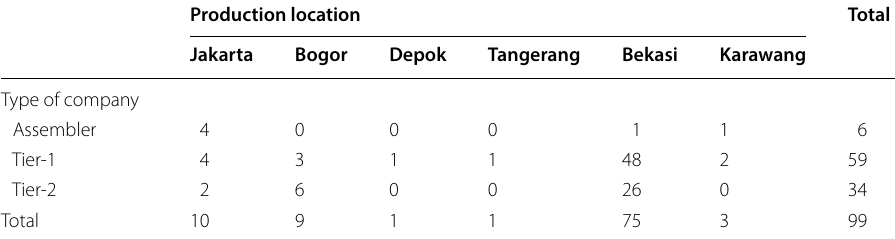
Table 3 Type of company based on production location. Source : Author Field Research